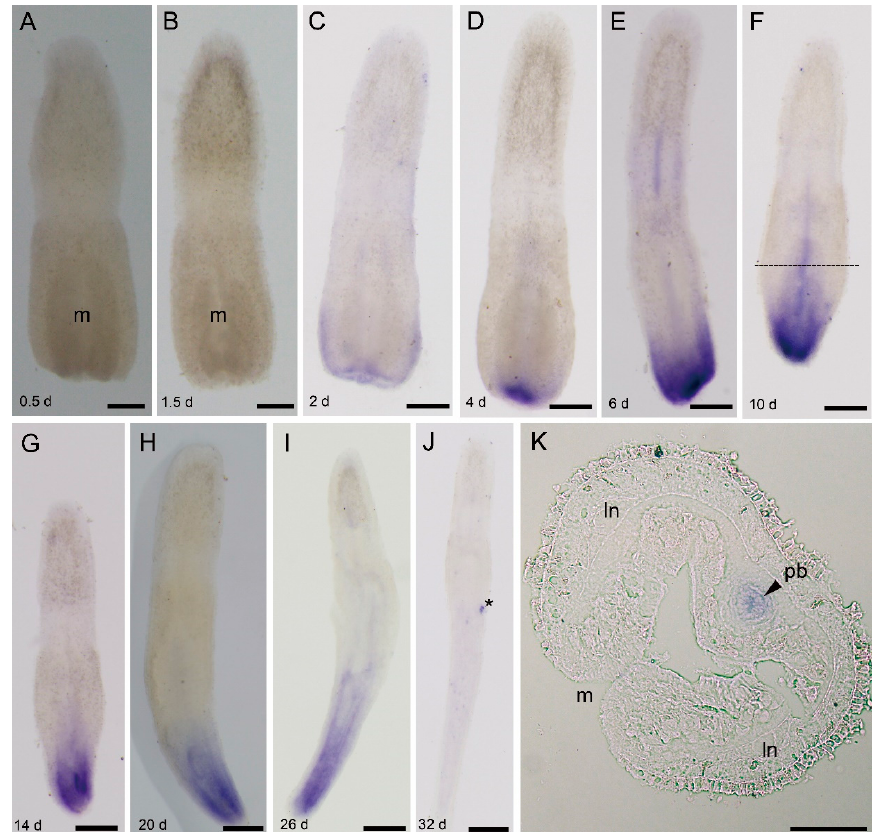
Figure 5. Ls-piwi1 expression during the posterior regeneration of Lineus sanguineus . ( A , B ) Images from 0.5 and 1.5 dpa, respectively, no positive staining. ( C ) Image from 2 dpa, weak expression around the wound site. ( D ) Image from 4 dpa, expressing at the center of the wound. ( E ) Image from 6 dpa, expressing in the posterior end and the proboscis. ( F ) Image from 10 dpa, expressing in the posterior end and proboscis (dashed line roughly showing the site of frozen section, see ( K )). ( G – I ) Images from 14, 20, and 26 dpa, respectively, expressing in the posterior end. ( J ) Image from 32 dpa, no positive staining. ( K ) Frozen section of a 10 dpa in situ hybridized specimen (same specimen as ( F )), showing the expression in proboscis. Abbreviations: ln, lateral nerve; m, mouth; pb, proboscis. Asterisks mark nonspecific staining (see Figure S4, Supplementary Materials). Scale bars: A–J = 250 μ m; K = 50 μ m.